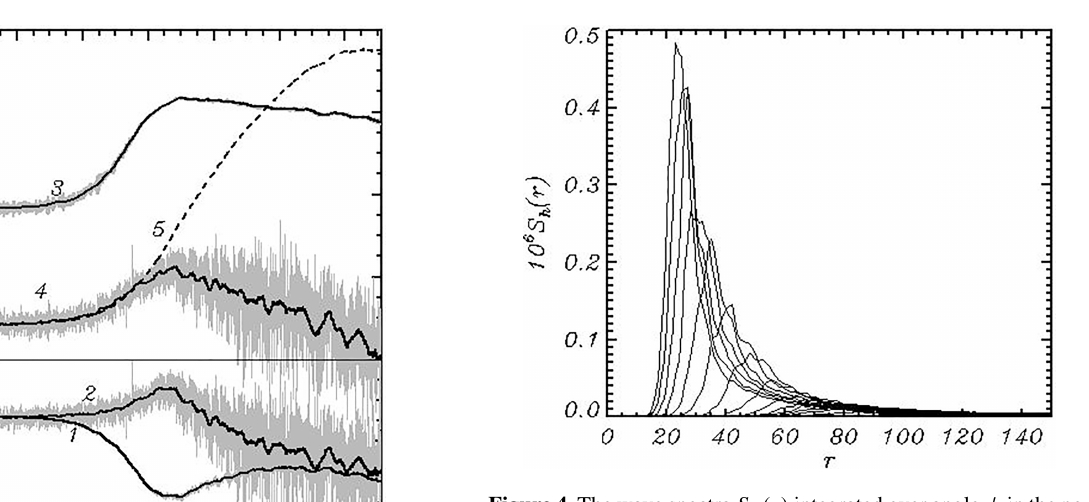
Figure 4. The wave spectra S h (r) integrated over angle ψ in the po- lar coordinates and averaged over the consequent intervals of length for about 100 units of the nondimensional time t . The spectra grow and shift from right to